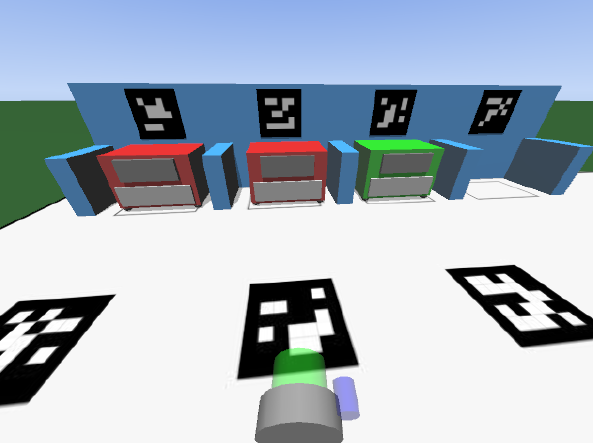
Figure 6. Example of an image taken by the robot’s camera in